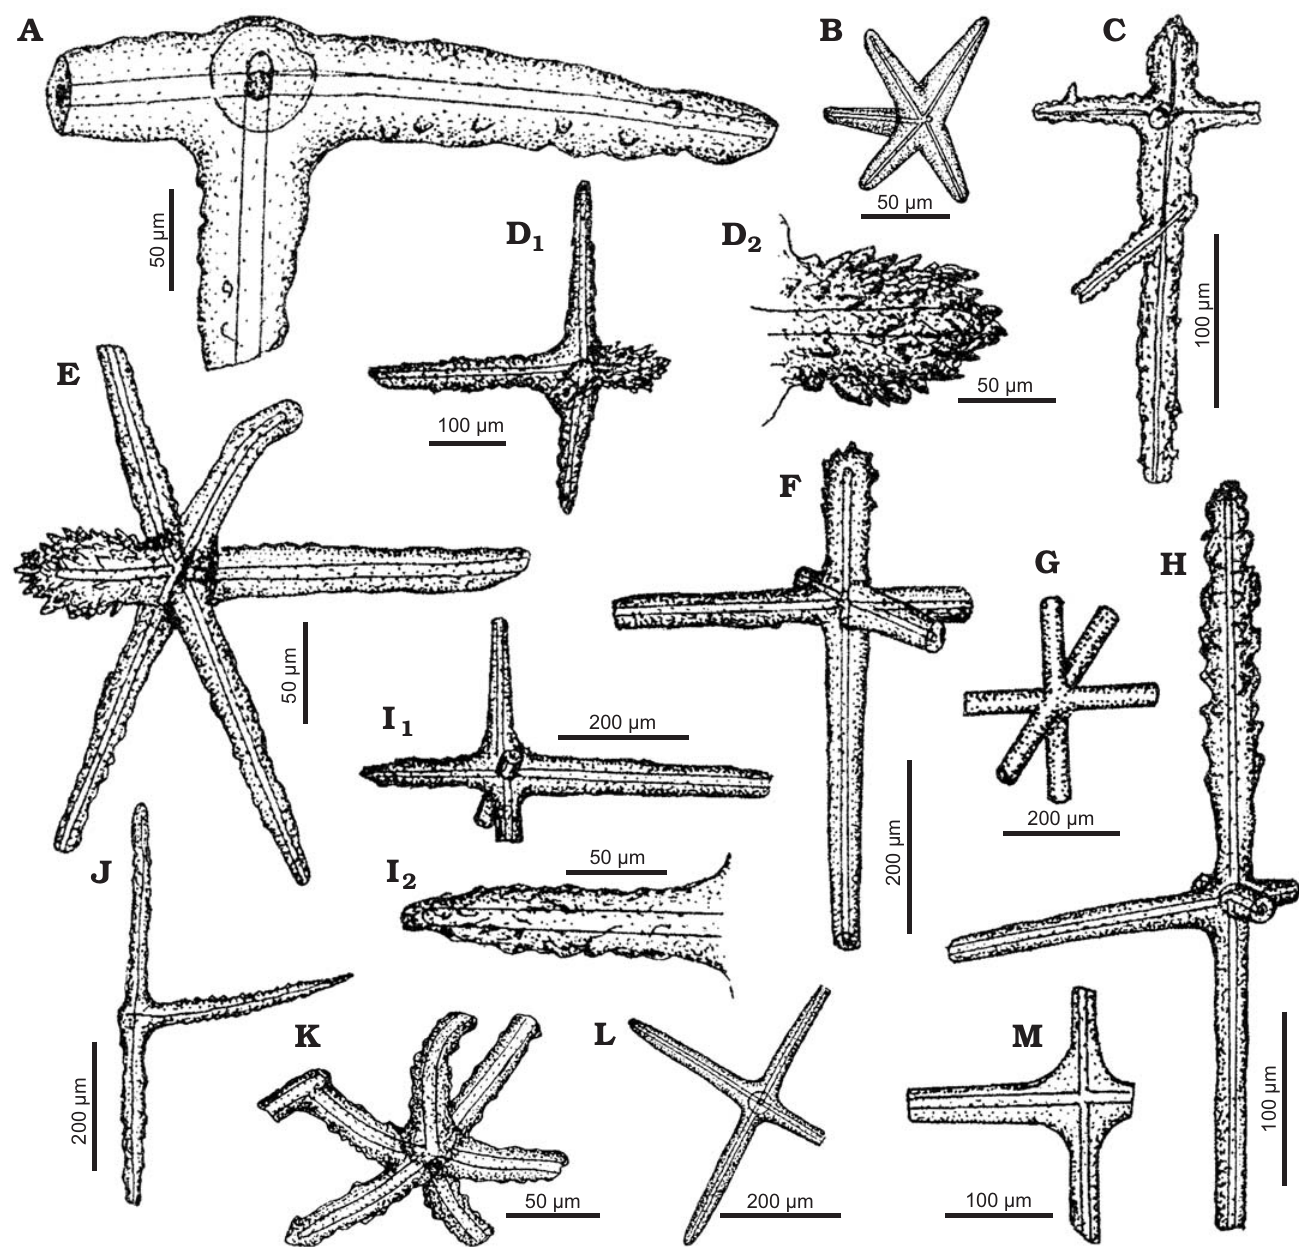
Fig. 10. Spicule morphotypes from south-central Ukraine; Kiselevka, middle Eocene (A, F, H, I, L), Staroverovka, middle Eocene (B), Nikol’skoe, up- per Eocene (C, D, E, J, M), Russkie Ti ŝ ki, upper Eocene (G), and Russkie Ti ŝ ki, middle Eocene (K). A , B . Pentactines. C – F , H , I . Pinnular hexactines. G . S mooth hexactine. J . Tautactine. K , L , Hexactines. M . Stauractine. After Ivanik (2003);